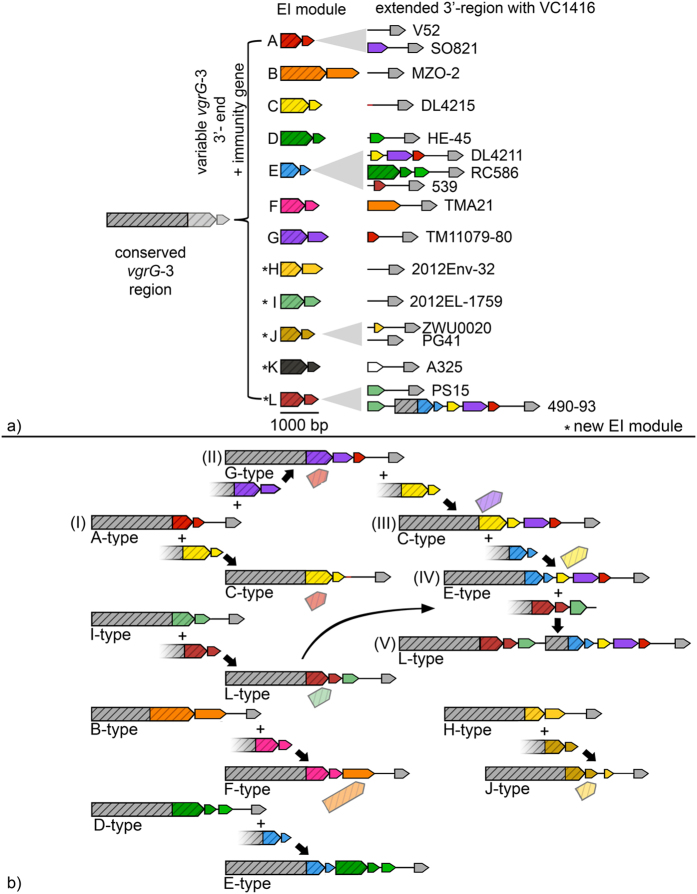
Organization and evolution of the Vibrio cholerae large T6SS cluster EI modules.(a) Large cluster EI module organization and variability. Conserved 5′-region of vgrG-3 can be tipped with different effector encoding 3′-regions and cognate immunity genes. (b) Recombinatorial reshuffling of vgrG-3. Cluster evolution proceeds by insertion of EI module and variable length of conserved vgrG-3 region into ancestral vgrG-3 gene. New EI module often (but not always) replaces original effector and shifts immunity gene(s) downstream. Integration of more complex EI clusters can result in larger clusters containing multiple EI components. Arrows indicate coding sequences, lines noncoding regions. Striped arrows denote genes encoding VgrG-3 effectors; non-striped arrows depict variable effector (large arrows) or immunity genes (small arrows). Colours indicate homology between either effector or immunity genes. Identically coloured effector and immunity genes are part of the same EI module. Grey arrows indicate conserved genes. Exact genomic locations can be found in Supplementary Table 2.